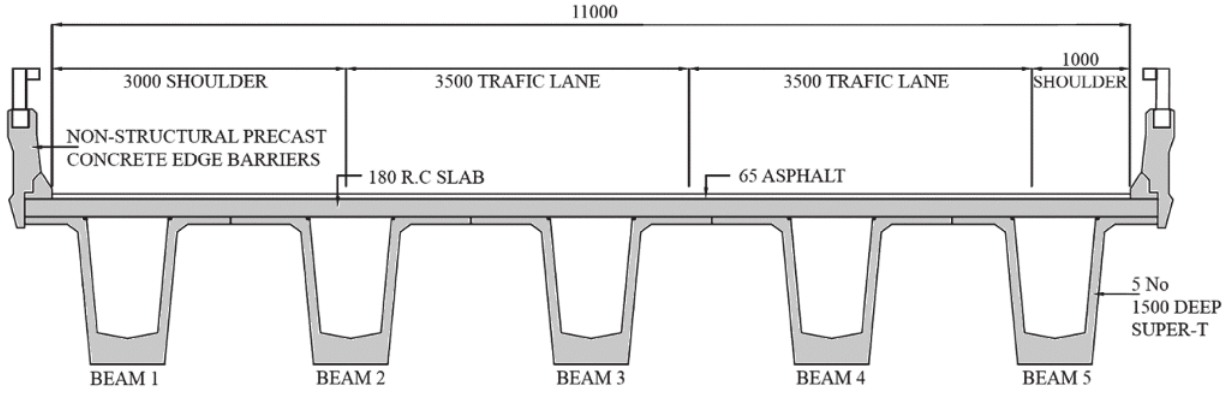
Bridge deck layout: Beams 1 and 5 have a 2100 mm top flange width, Beams 2 to 4 have a 2455 mm top flange width. All measurements are in mm (Caprani, Mayer e Siamphukdee[5]). Transversal beams only at